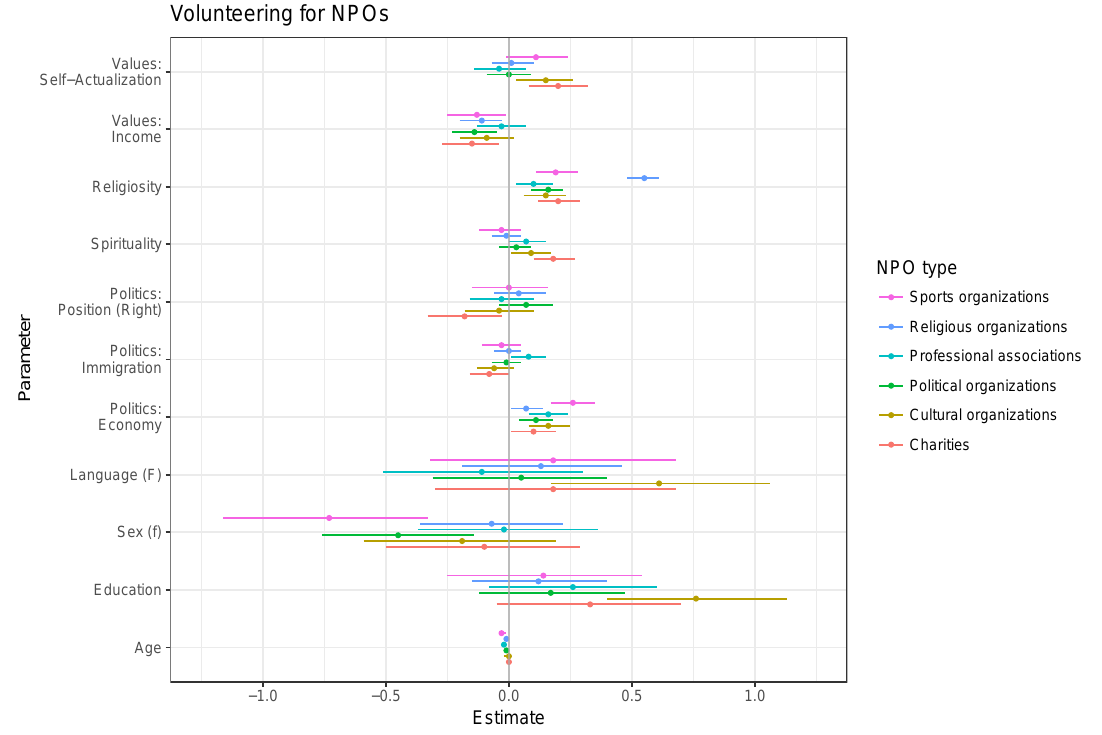
Figure 4. Parameter estimates for the six models with volunteering for an NPO as the response (dependent)